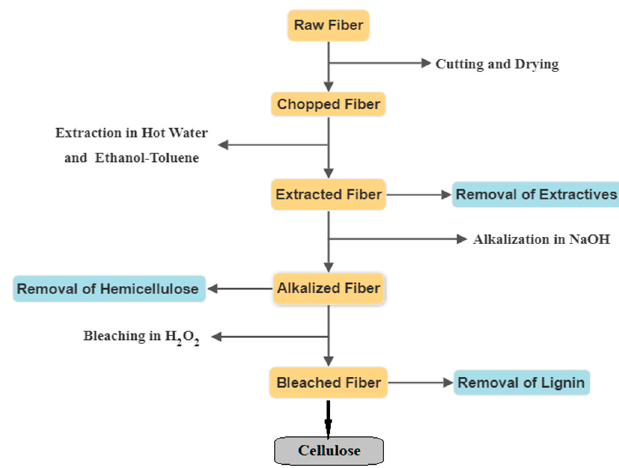
Figure 2. Flowchart of the cellulose-extraction process. Removal percentage of non-cellulosic components ( R %) of linseed fiber in each step